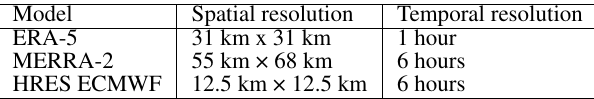
Table 1. Numerical weather models data characteristics.